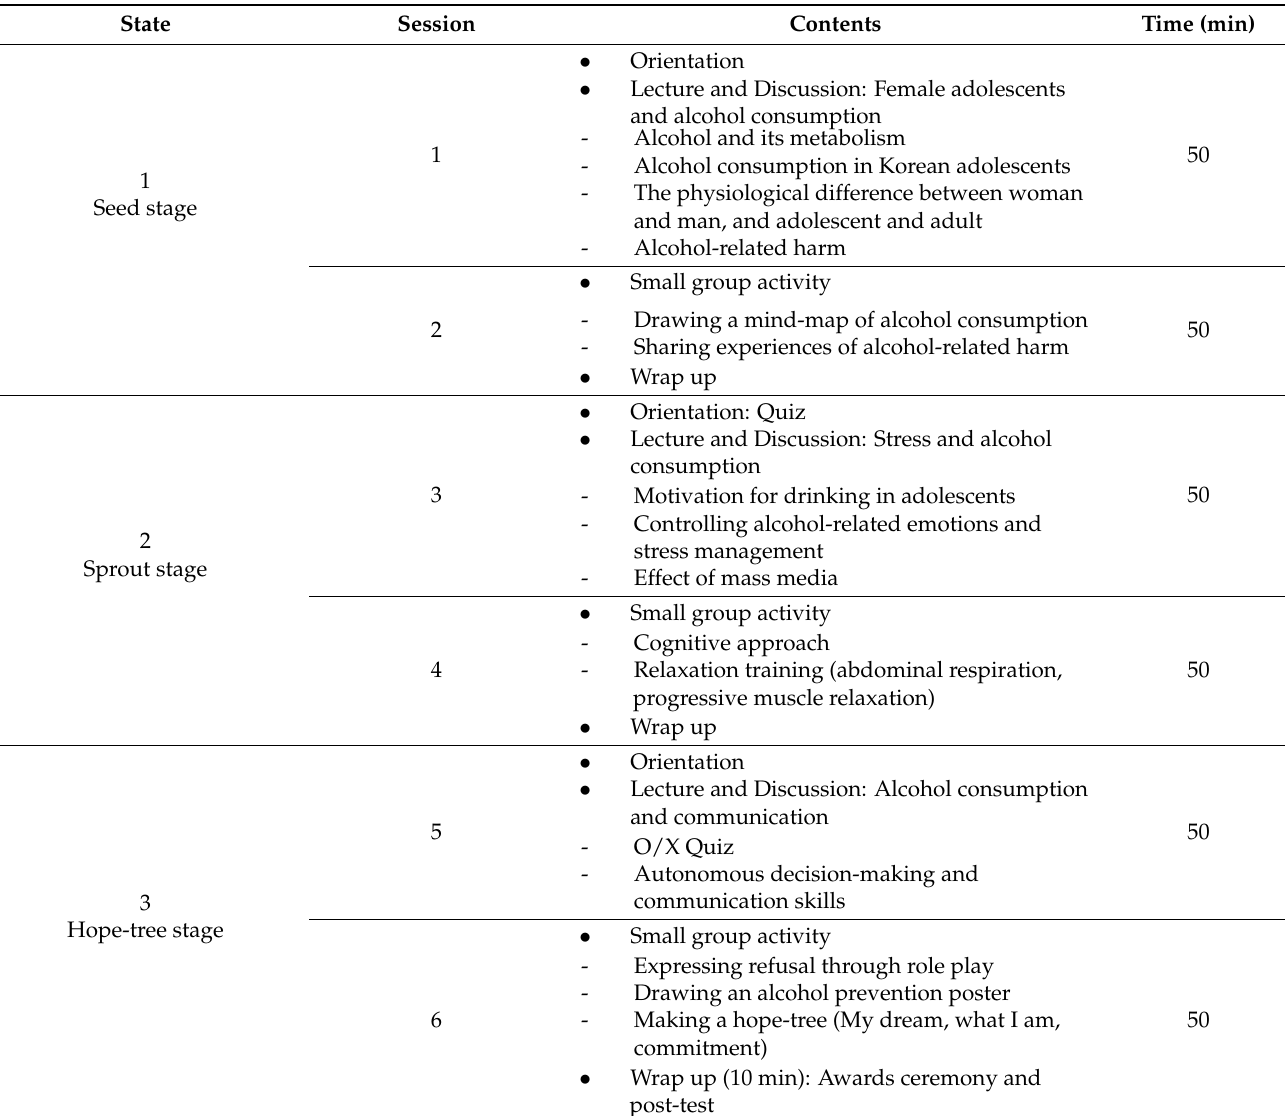
Table 2. Sessions and contents of the alcohol-related harm prevention